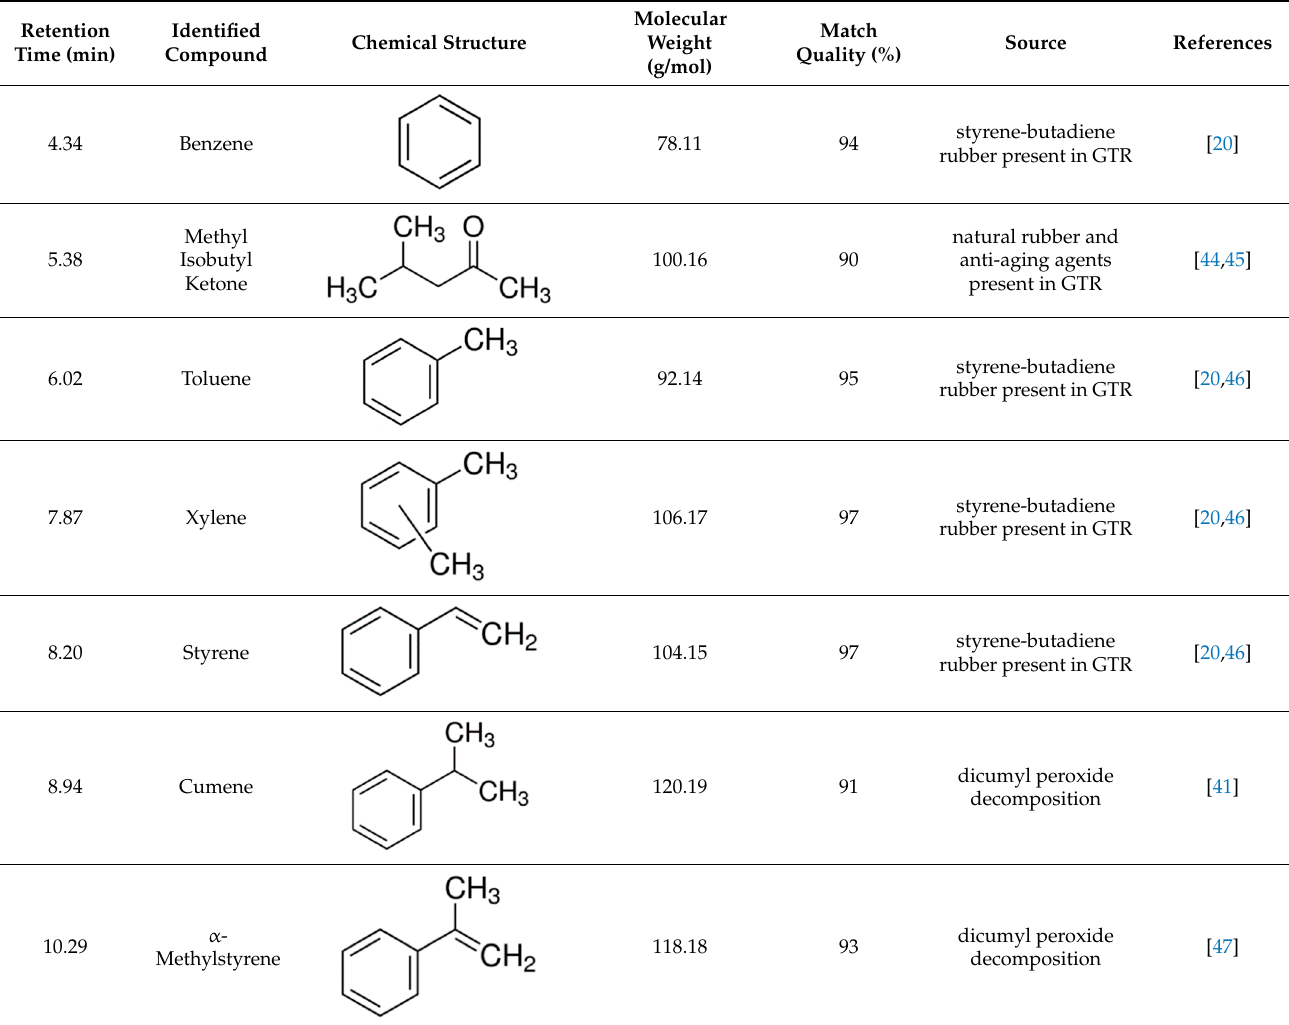
Table 4. Volatile organic compounds identified by GC-MS measurement during preparation (reactive extrusion) of modified GTR—sampling via Radiello ® diffusing sampling system .